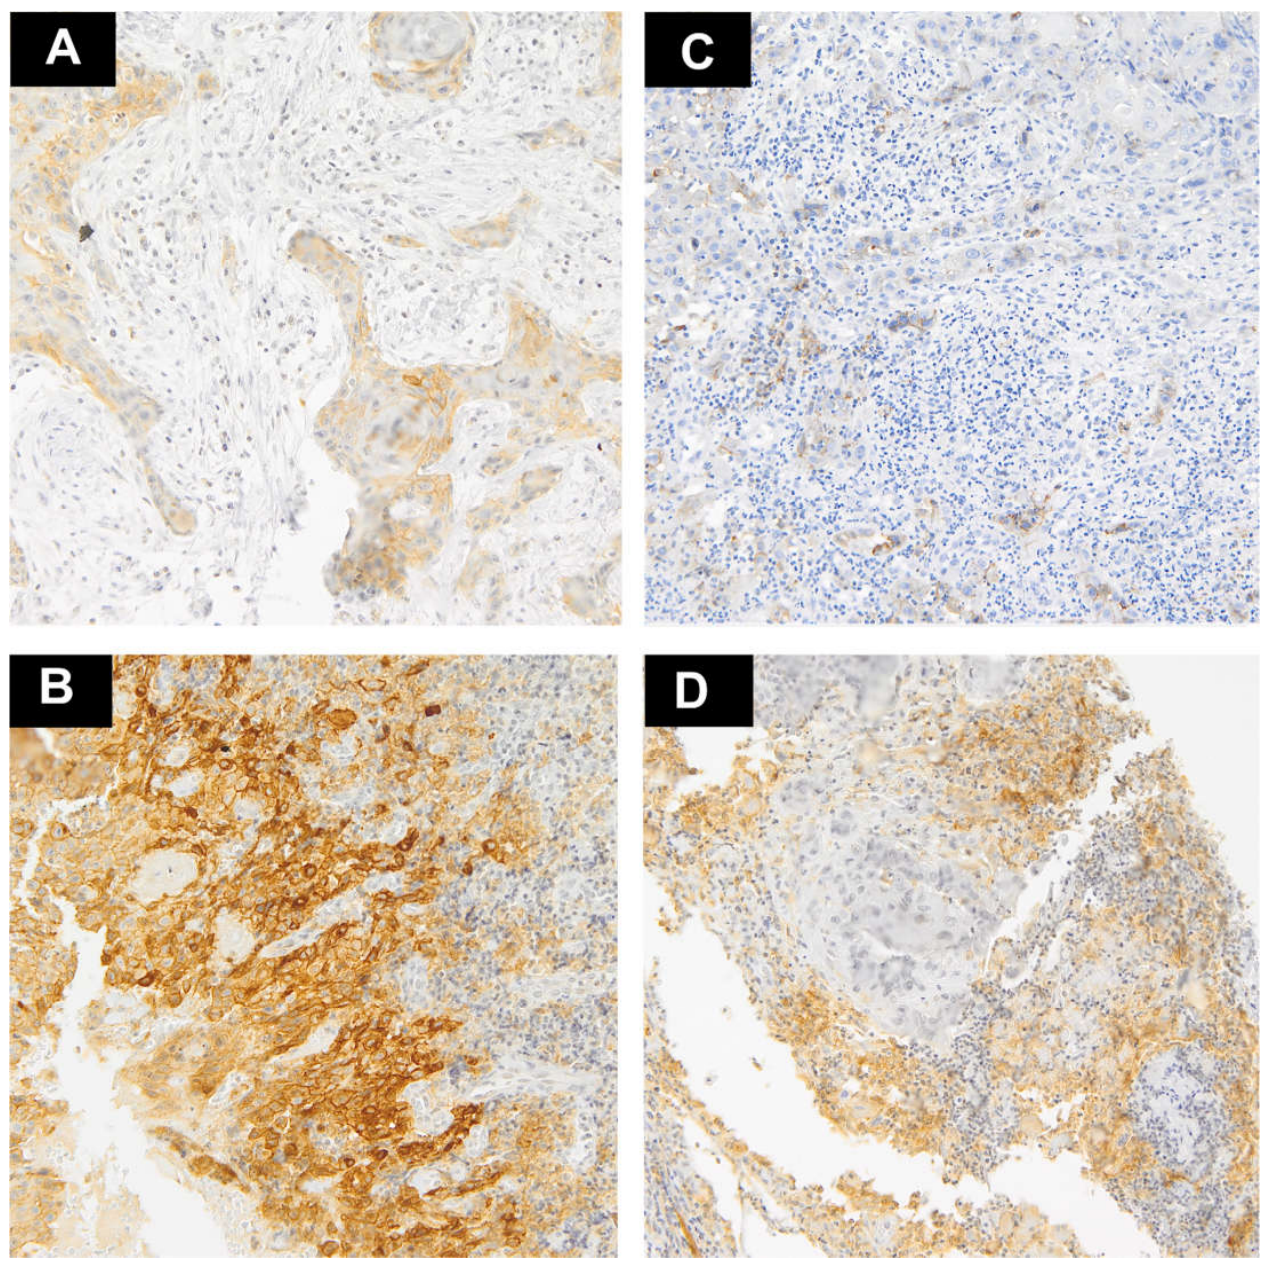
Figure 1. Representative examples of PD-L1 staining (magnification ×10). ( A ) A few tumor cells with weak expression of PD-L1; ( B ) Intense expression of PD-L1 in the majority tumor cells and weak staining in TILs at the tumor–stroma interface; ( C ) Very weak expression of PD-L1 on single lymphocytes and negative on cancer cells; ( D ) High expression of PD-L1 on TILs at the tumor–stroma interface and negative on tumor cells.